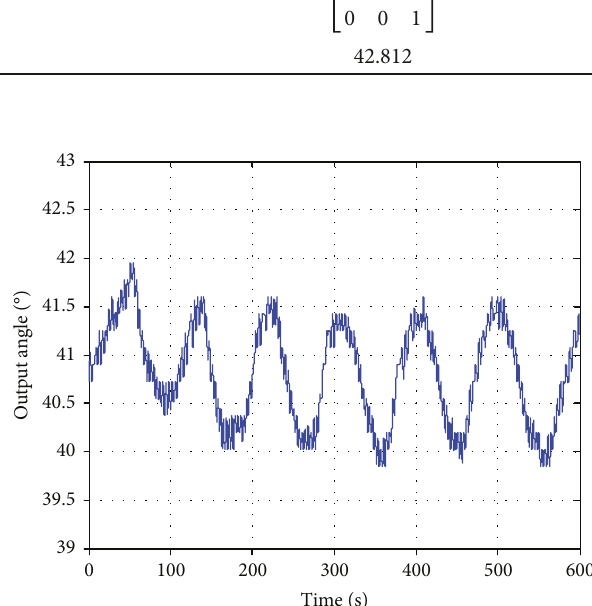
Figure 6: The output angles of the photoelectric encoder used in the experiment system in Figure